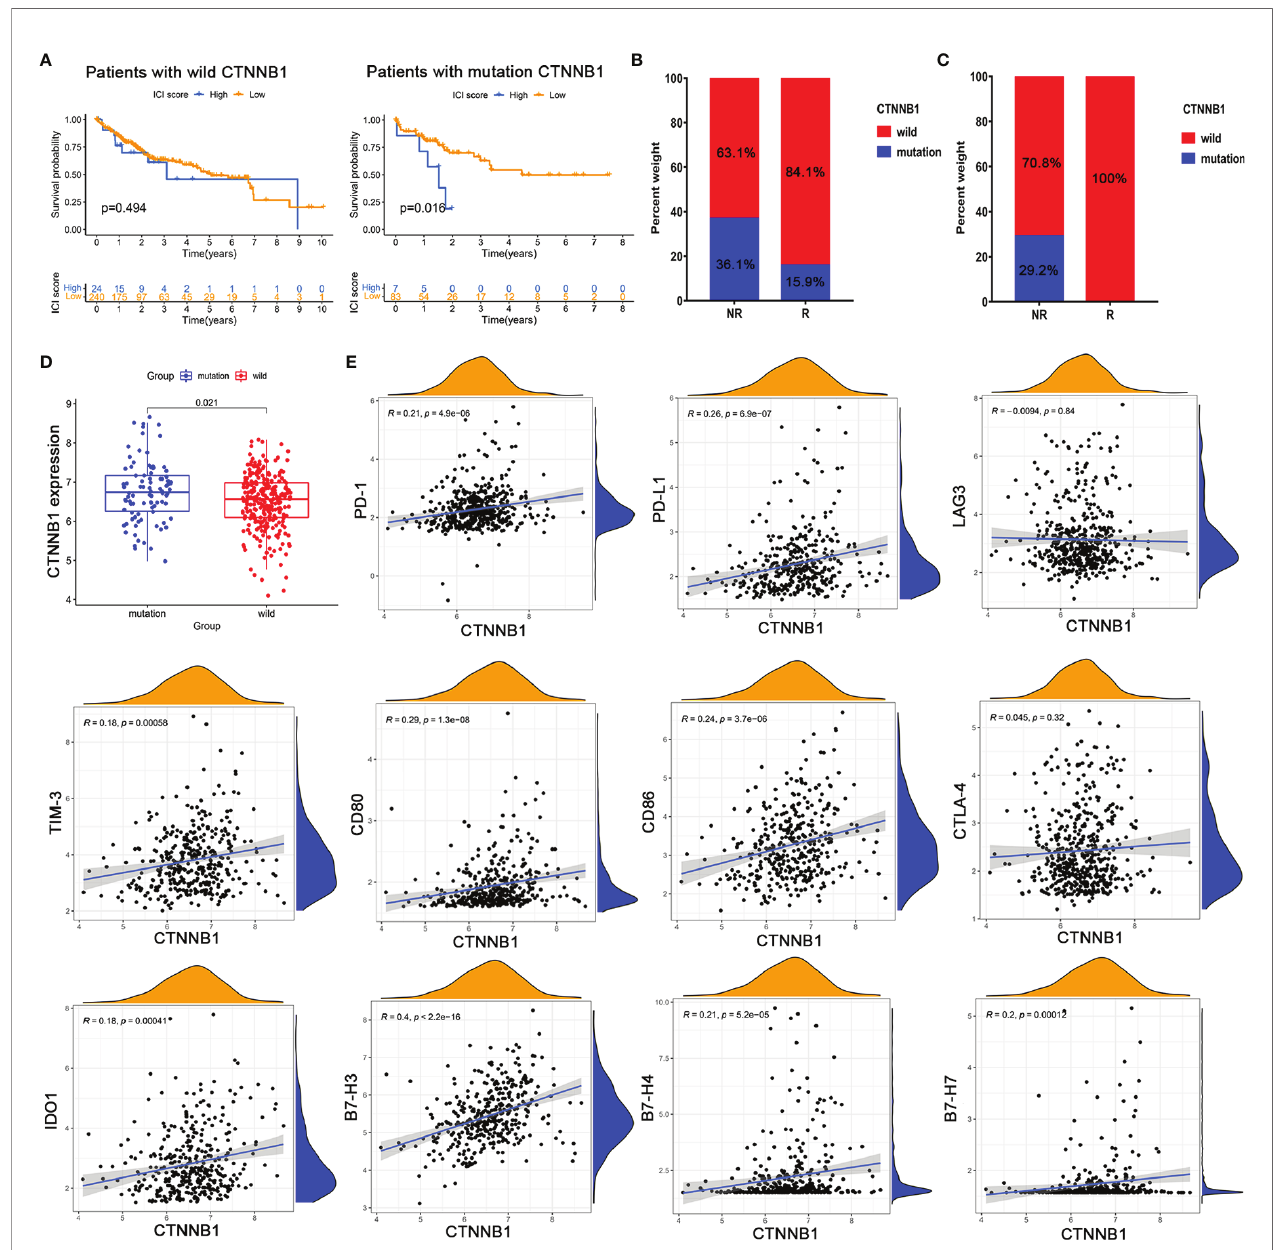
FIGURE 7 | (CTNNB1 mutation might be predictive of response to immunotherapy. Kaplan – Meier survival curve of the (A) CTNNB1 wild-type group and (B) CTNNB1 mutation group in TCGA-LIHC. (C) CTNNB1 mutation status in the response and non-response groups from TCGA-LIHC (left) and cBioPortal database (right). (D) Comparison of the expression of CTNNB1 in wild-type and mutant groups. (E) Correlation between CTNNB1 expression and T-cell checkpoint